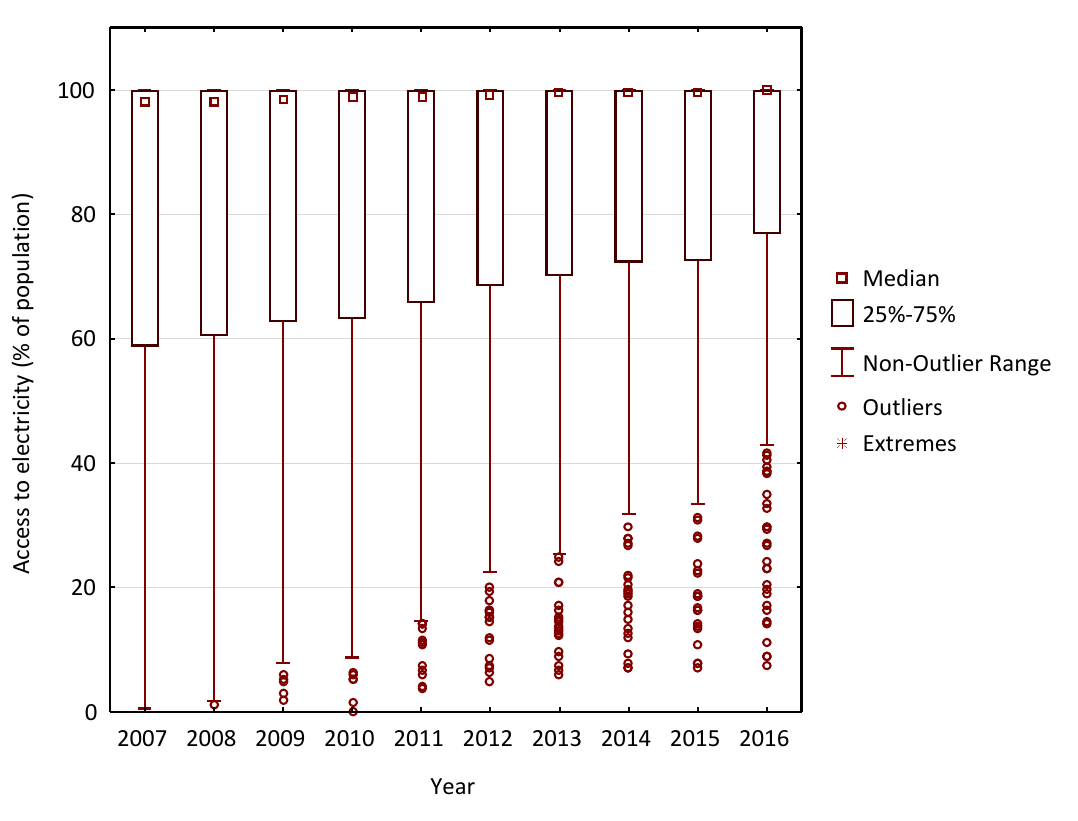
Figure 1. Access to electricity throughout the world in 2007–2016, % of